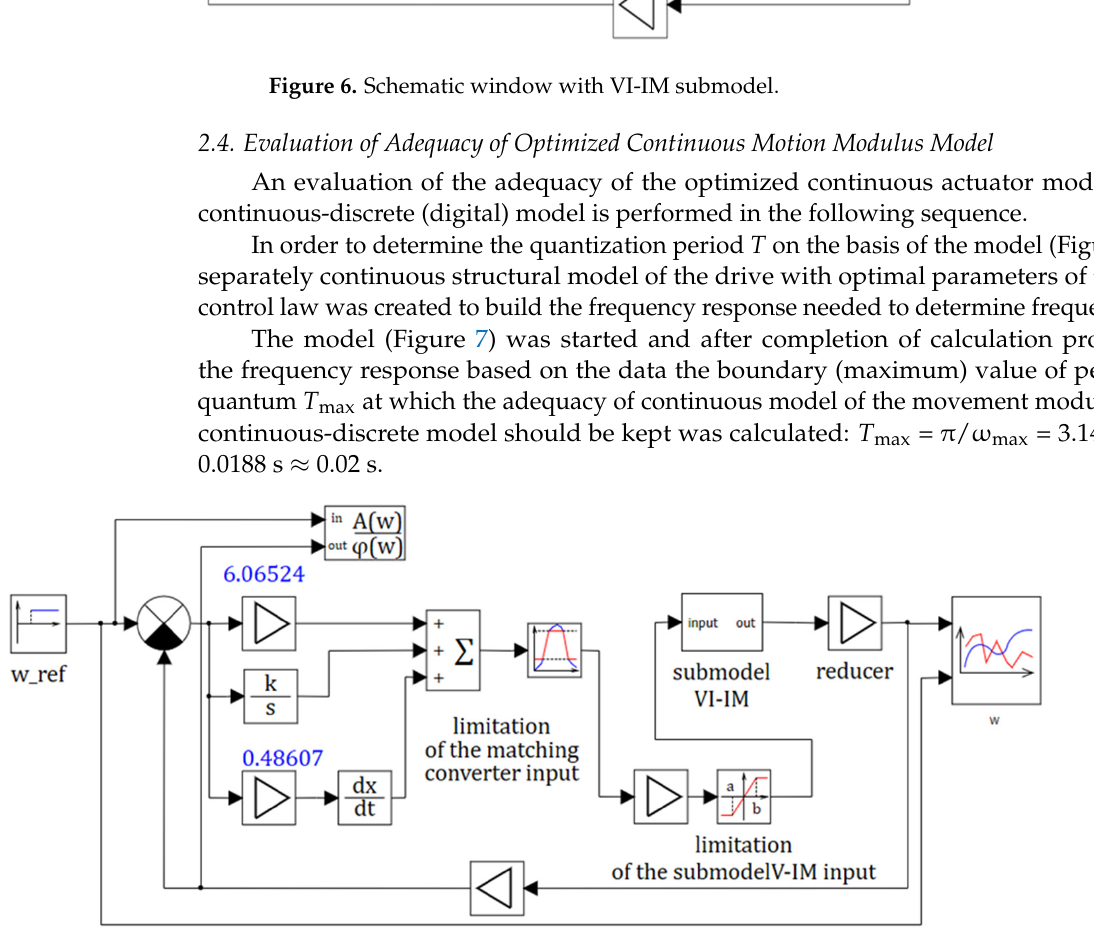
Figure 7. Schematic window with the model for plotting the frequency response of continuous actuator structural model with optimal parameters of PID control law.